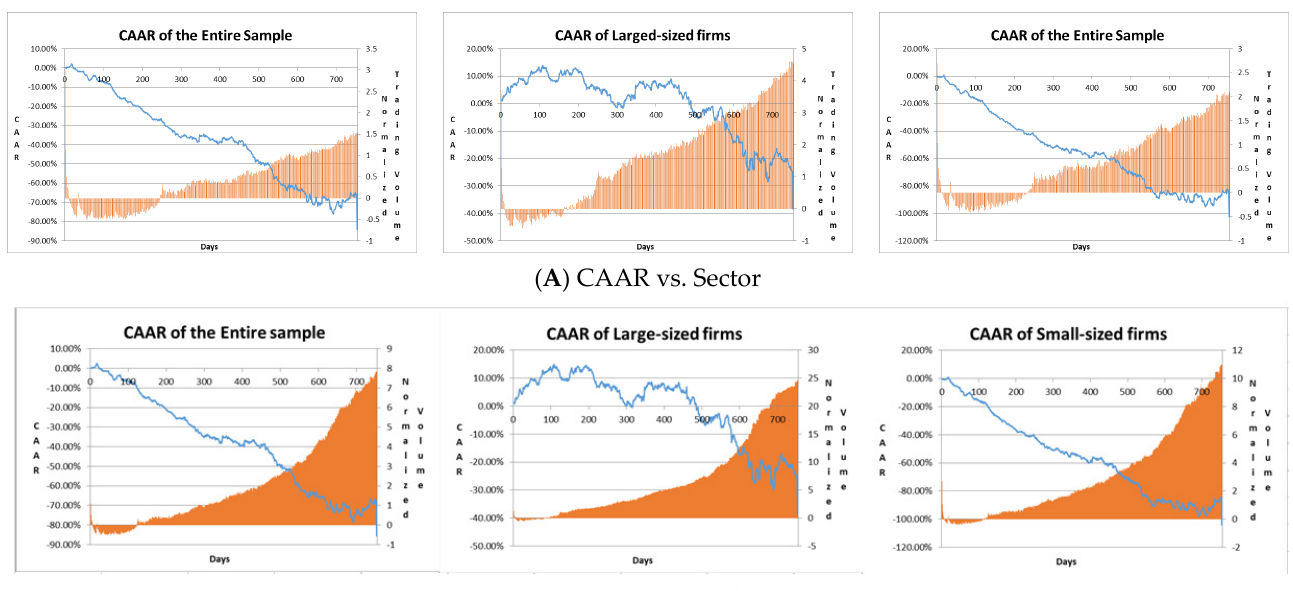
Figure 1. Post-IPO CAARs, +1 to +755 days. Note: These figures present the daily CAAR from day 1 to day 755 after the IPO. Panel ( A ) presents the CAAR calculated versus the sector index. Panel ( B ) displays the CAAR calculated versus the S&P500.